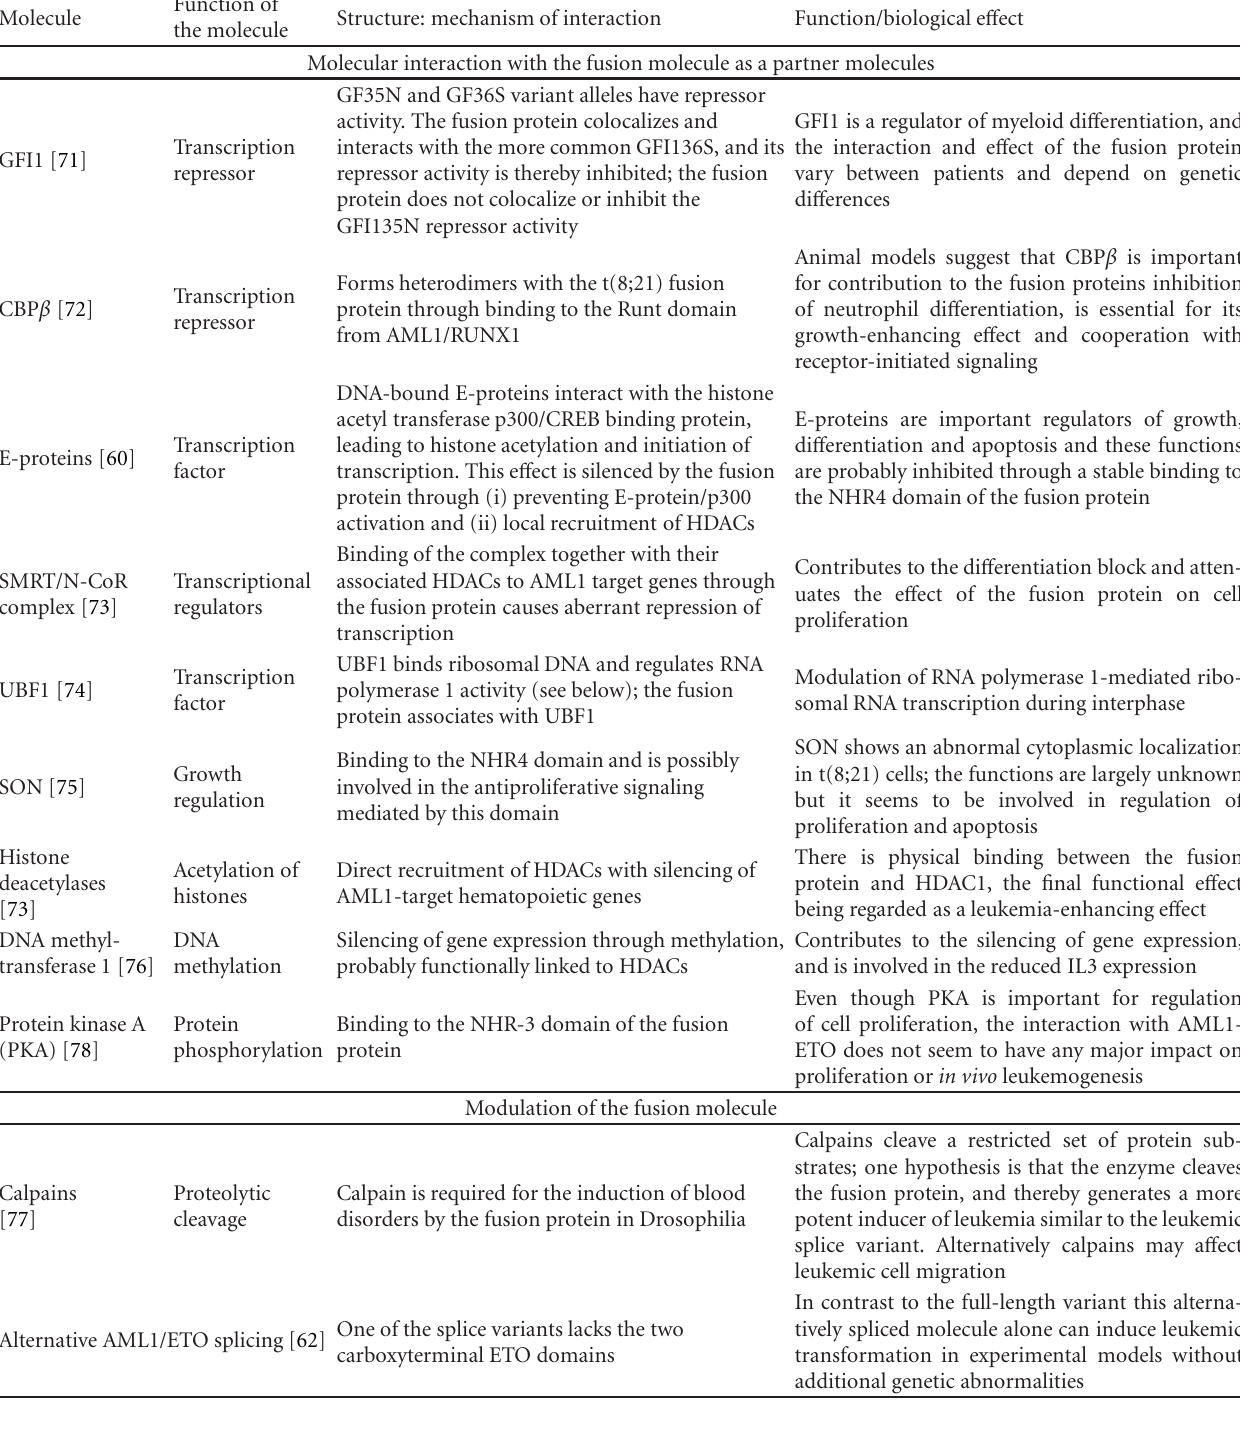
Table 3: Important proteins that directly interact with or modulate the t(8;21) fusion